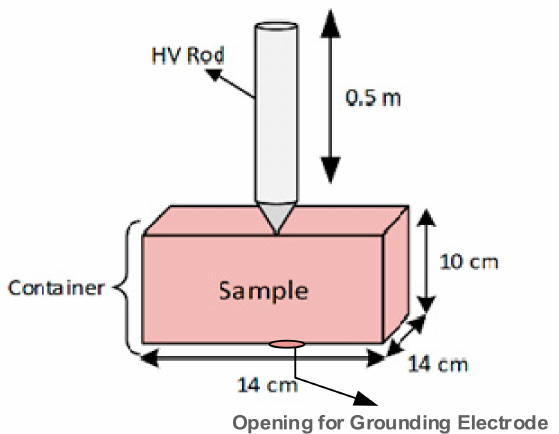
Figure 5. Dimensions for the test